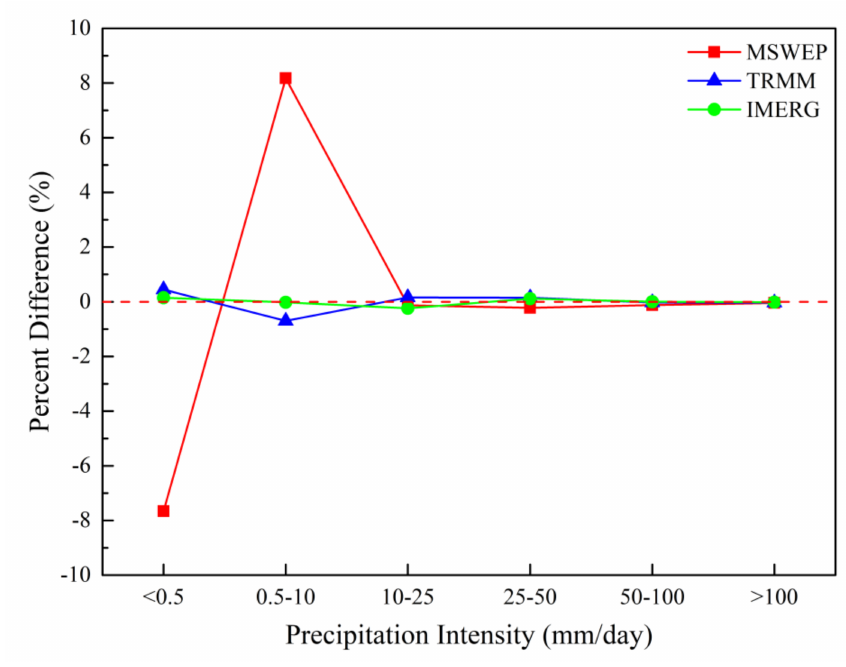
Figure 9. The percent difference between the occurrence frequency distribution of each precipitation product and that of the ground observations for a range of rainfall